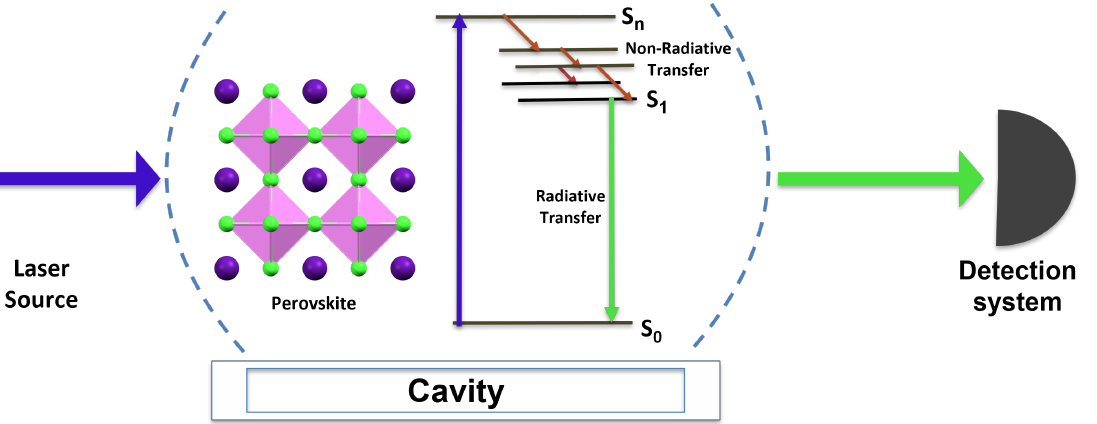
Figure 1. Scheme of Quantum Filigran experiment. The blue arrow represents the light emitted by the laser, resonant with the peak of absorption of the fluorophore (440 nm). The green arrow represents the emitted photon. Note that in the strong coupling regime, photons are emitted at two possible wavelengths (530 25 nm), a manifestation of frequency ±